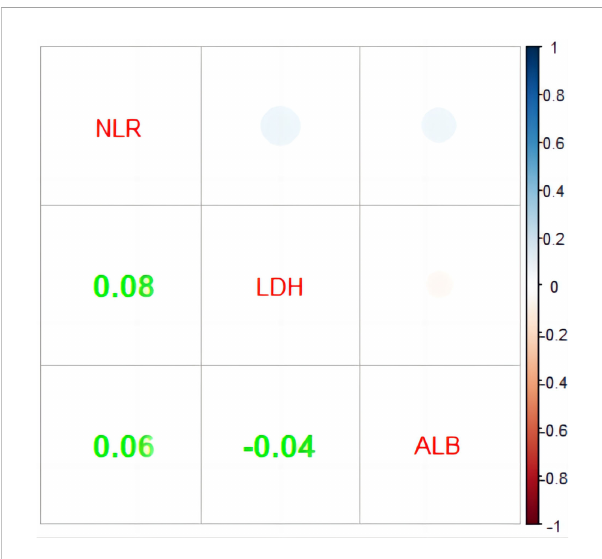
FIGURE 3 Correlation analysis of NLR, LDH, and ALB. NLR, neutrophil-to- lymphocyte ratio; LDH, lactate dehydrogenase (IU/L); ALB, albumin